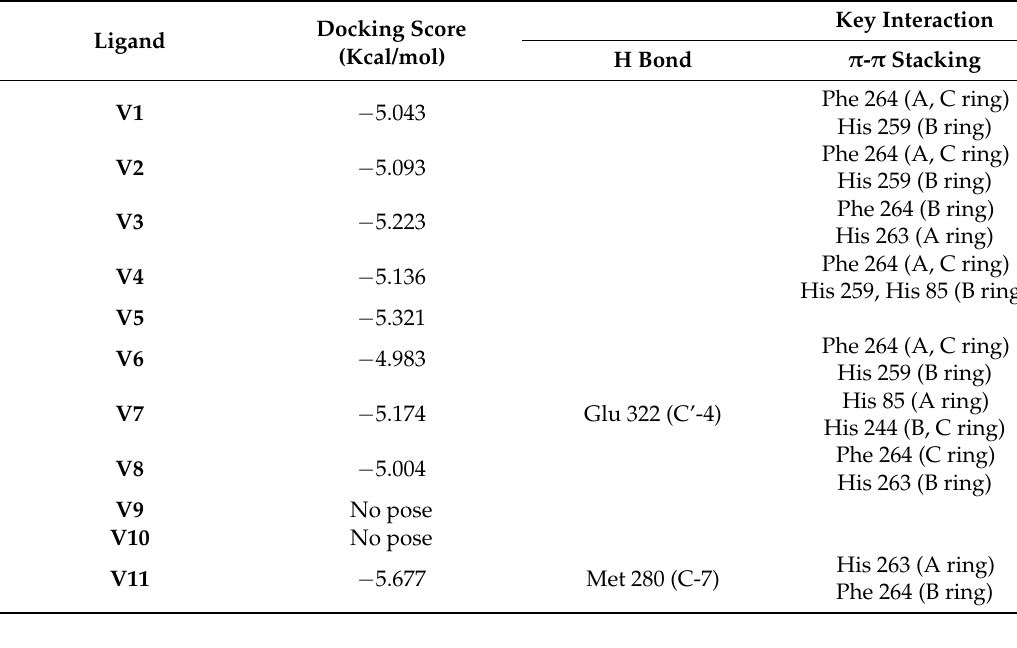
Table 3. Binding sites and docking scores of velutin derivatives in tyrosinase.